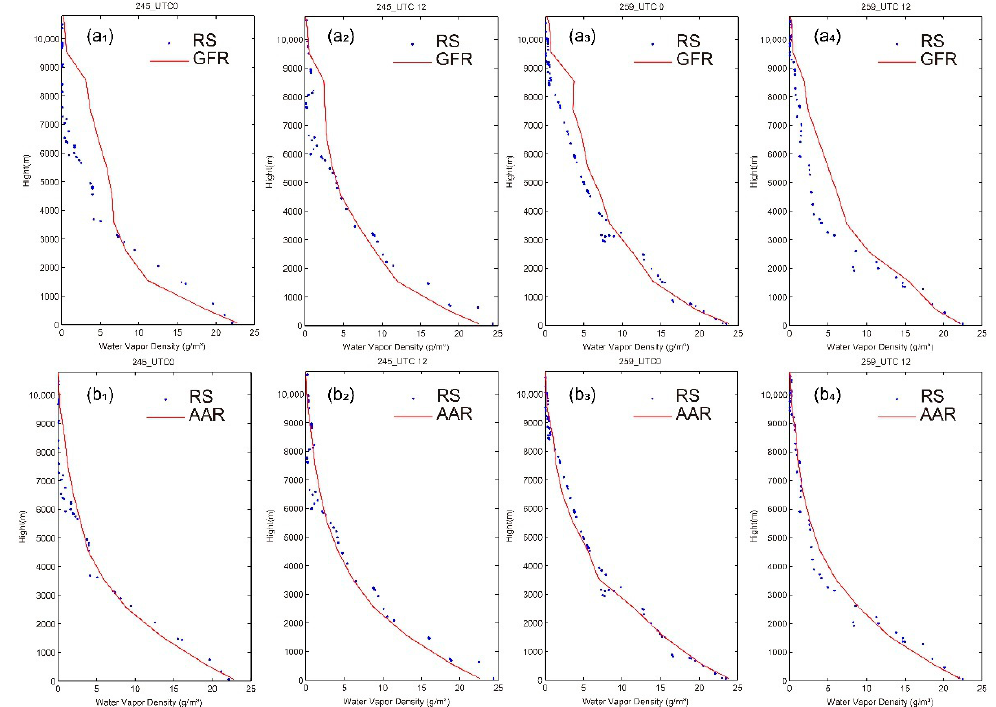
Figure 6. Tomographic water vapor profiles (red lines) at UTC 0 and UTC 12 on DOY 245 and DOY 259 in 2020 were compared with the sounding data from HKKP (blue dots). ( a 1 – a 4 ) GFR reconstructs water vapor profiles. ( b 1 – b 4 ) AAR reconstructs water vapor profiles.